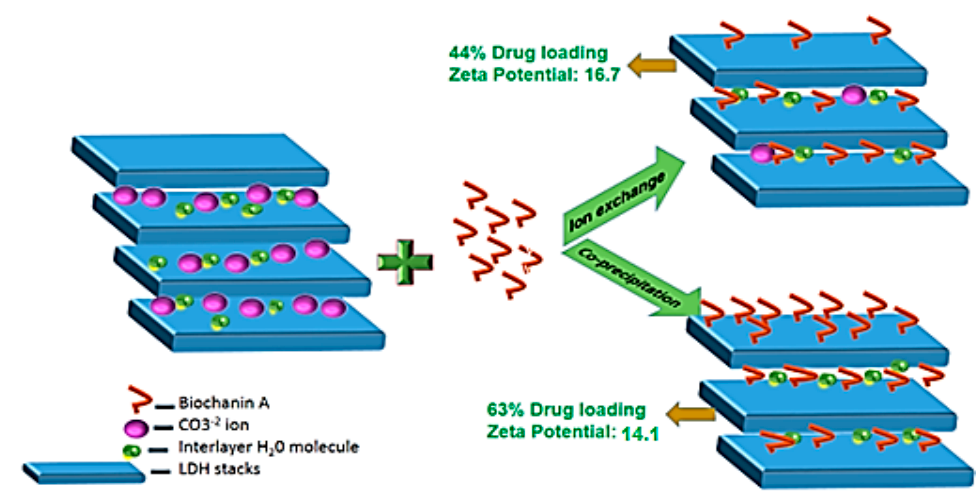
Figure 13. Schematic representation of drug loading in LDH nanoparticles by ion exchange and co-precipitation.